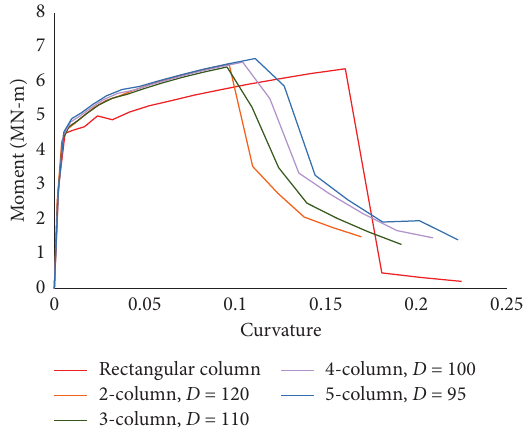
Figure 13: Moment-curvature diagrams of the different pier systems.